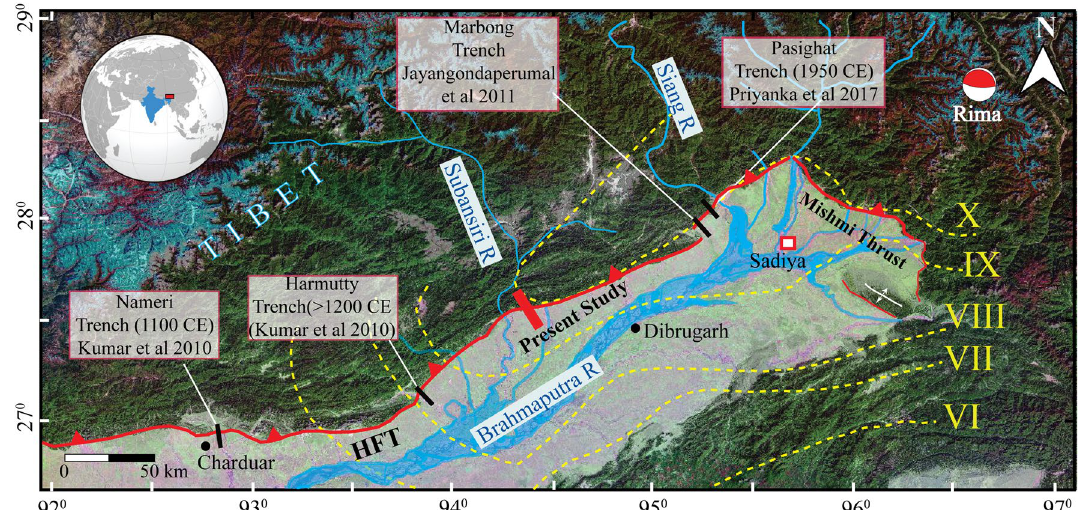
Figure 1. Regional map of the eastern Himalaya draped on Shuttle Radar Topographic Mission (SRTM) and Landsat satellite imagery. Solid black lines show locations of previous trenches. The solid red line shows the trench location of this study. Yellow dotted lines with Roman numerals are the 1950 CE earthquake isoseismals 51 . Red beach ball shows location of 1950 CE earthquake epicenter 32 . Red square with white fill is the reported maximum actual damage during the 1697 CE Sadiya earthquake 1 . The moment tensor solution (red beach ball) of the 1950 CE earthquake by Coudurier-Curveur et al. 18 shows a double couple solution